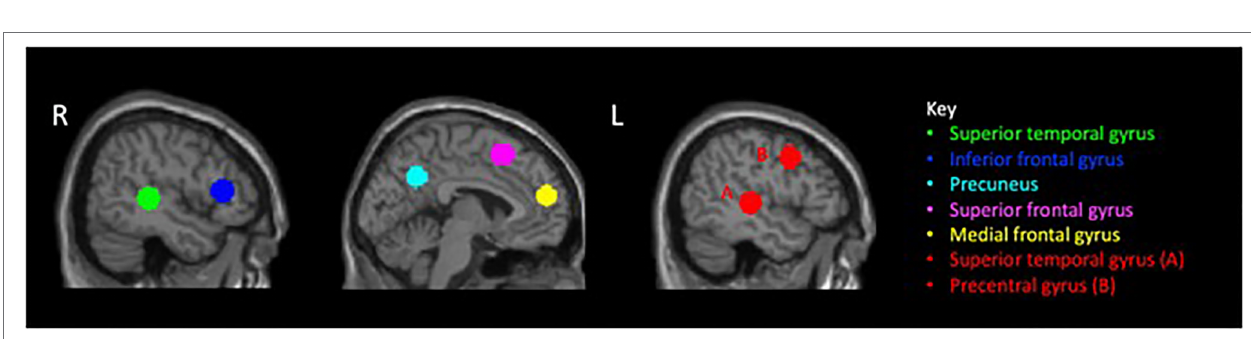
FIGURE 3 | Region of interest from meta-analysis of Molenbergh (2016).